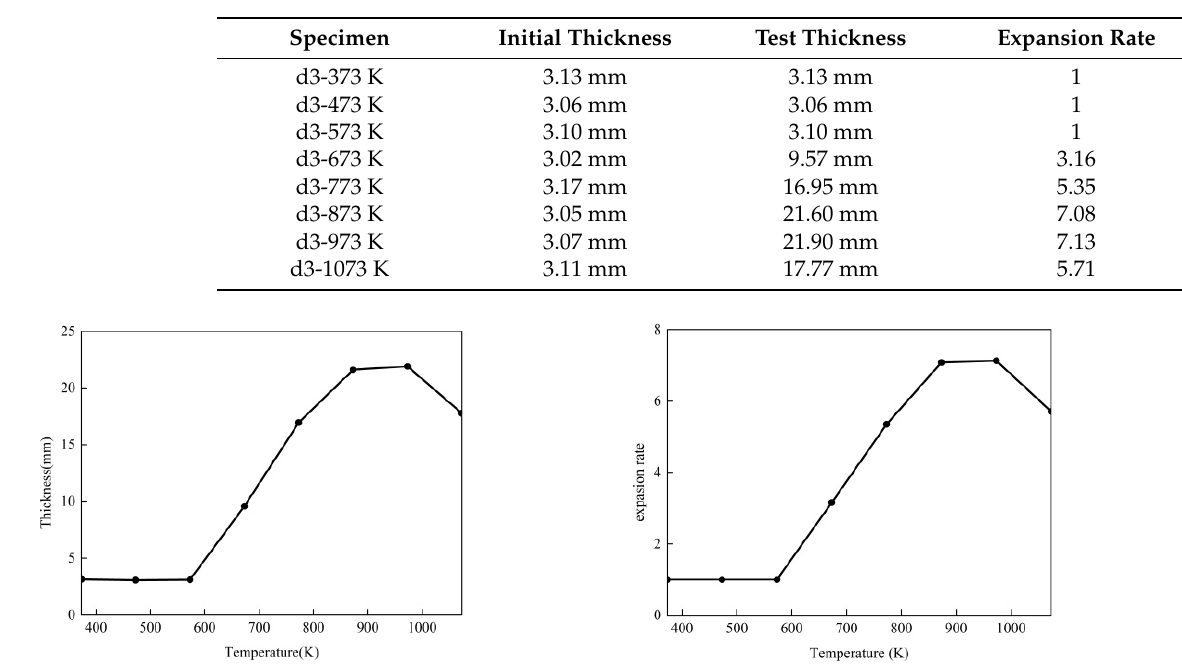
Table 1. Thickness and expansion rate (d3-373 K indicates the initial thickness is 3 mm and the experiment temperature is 373 K).